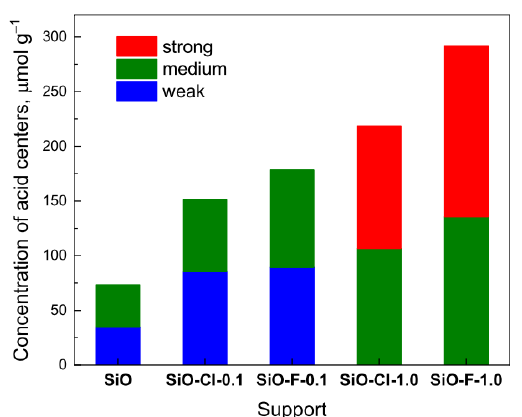
Figure 3. Concentration of different types of acid centers on the surface of indicated silica materials calculated from NH 3 -TPD studies.